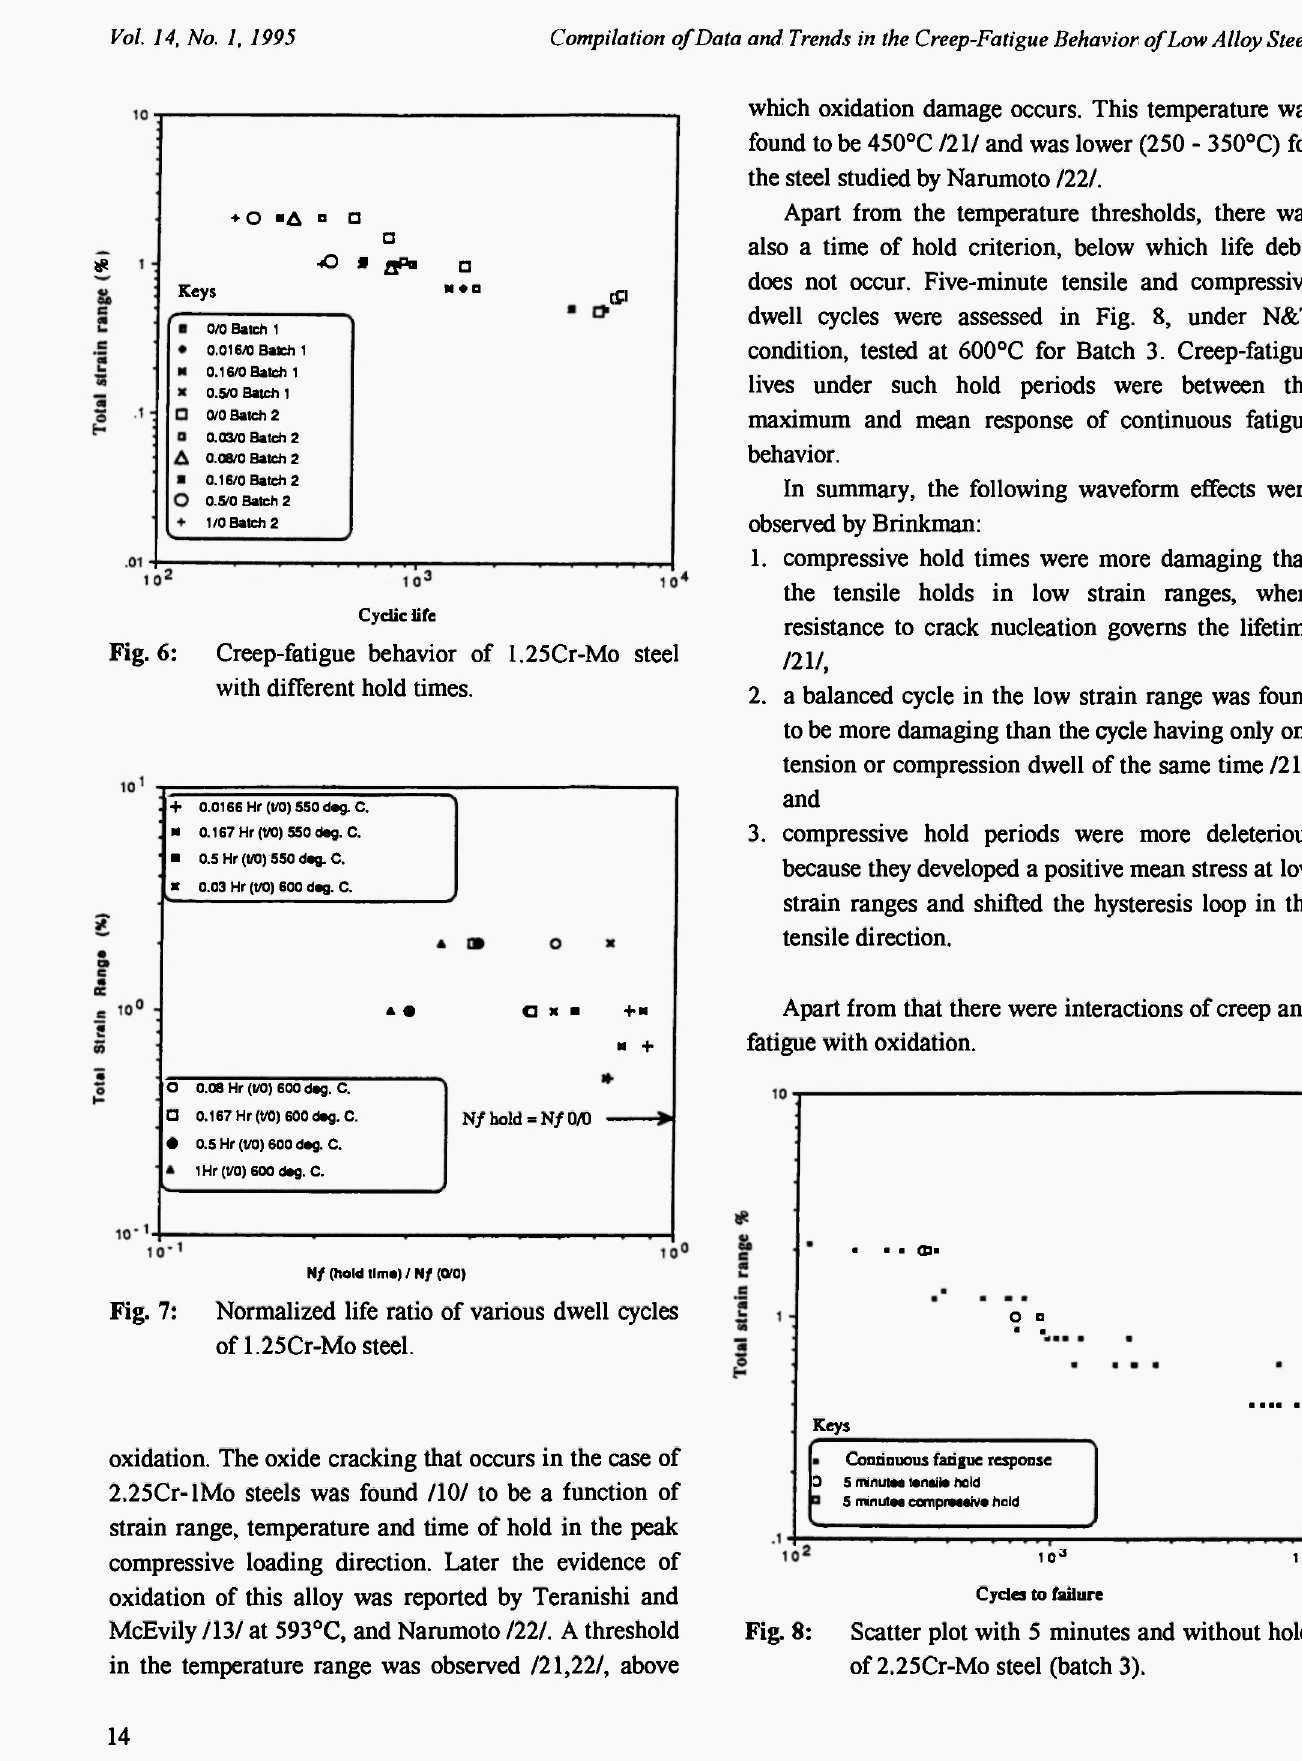
Fig. 7: Normalized life ratio of various dwell cycles of 1.25Cr-Mo steel.